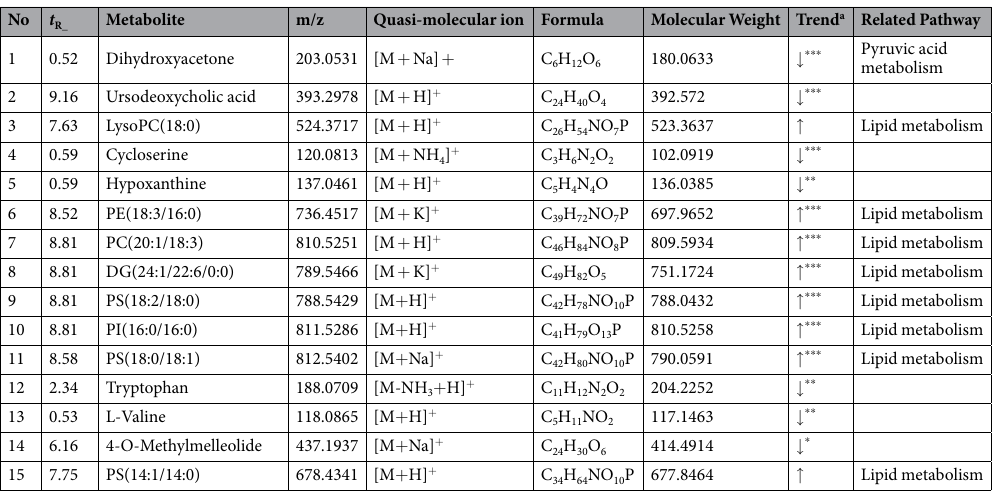
Table 1. 15 Biomarkers of resistant-ascites syndrome detected using ultra-performance liquid chromatography-quadruple time-of-flight high-sensitivity mass spectrometry (UPLC Q-TOF/MS) in positive ion mode on day 21. a Change trend of resistant vs susceptible. Levels of potential biomarkers were labelled with ( ↓ ) downregulated and ( ↑ ) upregulated. * P < 0.05, ** P < 0.01, and *** P <